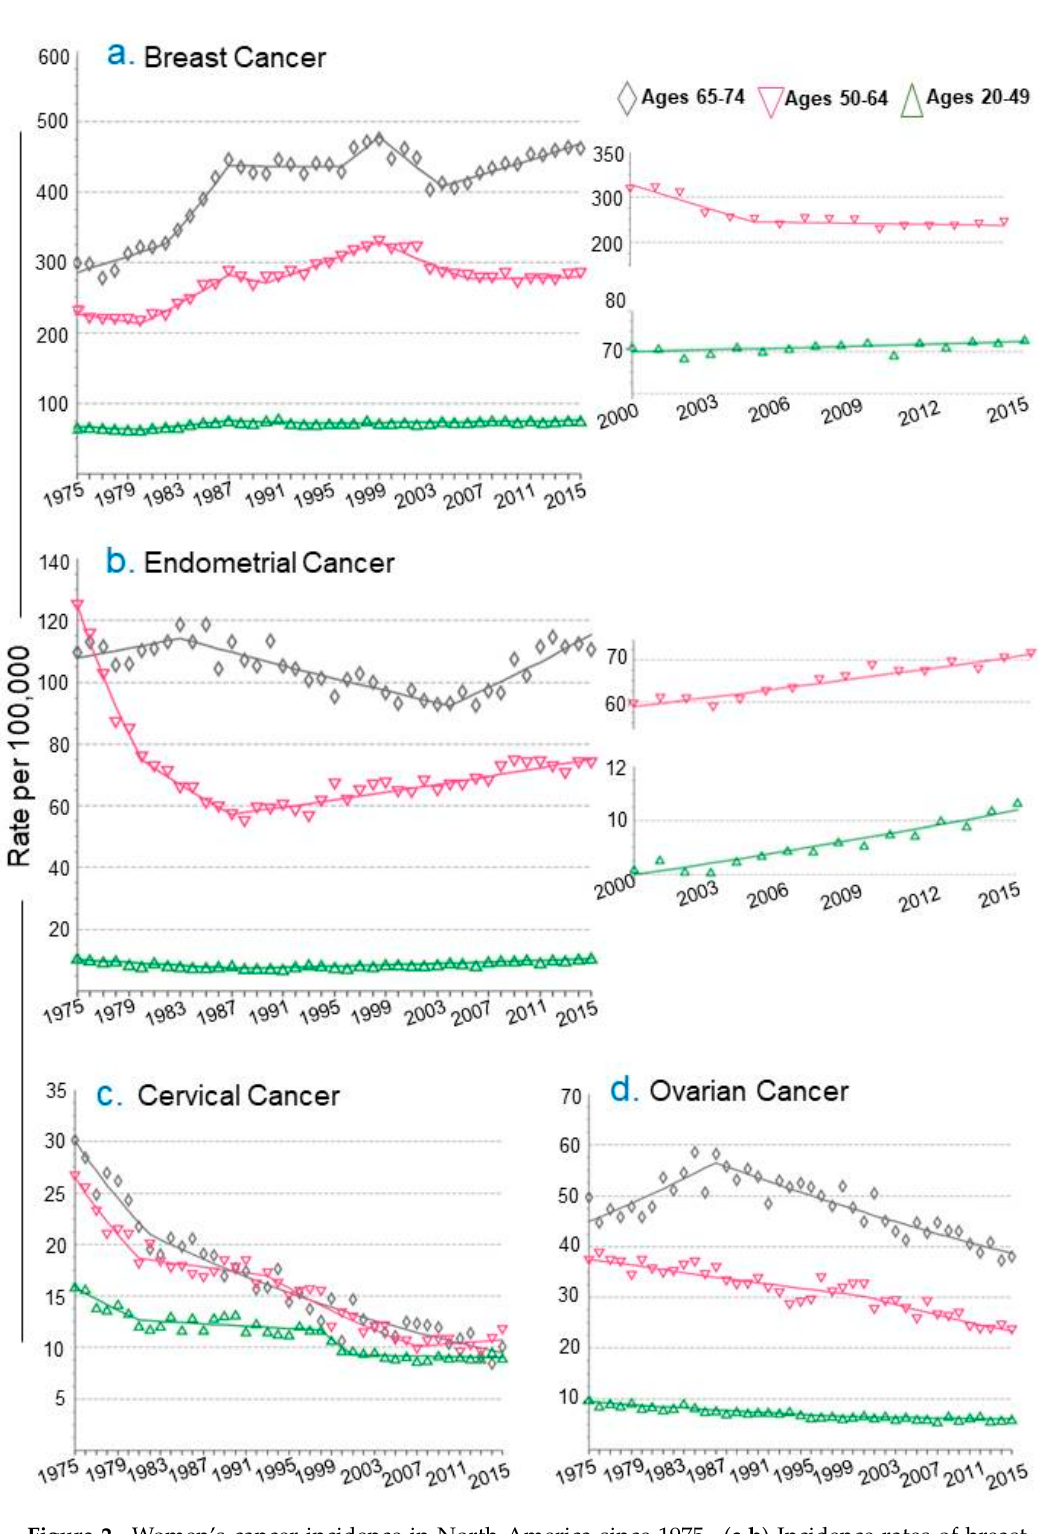
Figure 2. Women’s cancer incidence in North America since 1975. ( a,b ) Incidence rates of breast and endometrial cancer as per age-groups. Right inserts, partial enlargements of incidence for two age-groups from 2000–2015. ( c,d ) Incidence rates of cervical and ovarian cancers as per age-groups.